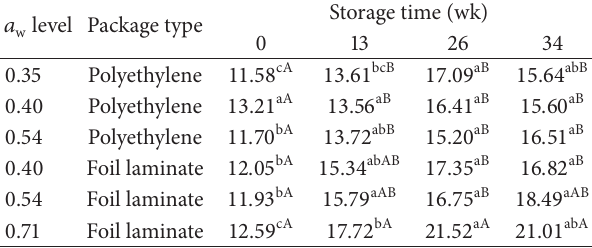
Table 4: Changes in 𝑏 ∗ ( ± , blue/yellow) color values of dehydrated taro slices stored at different 𝑎 materials 1